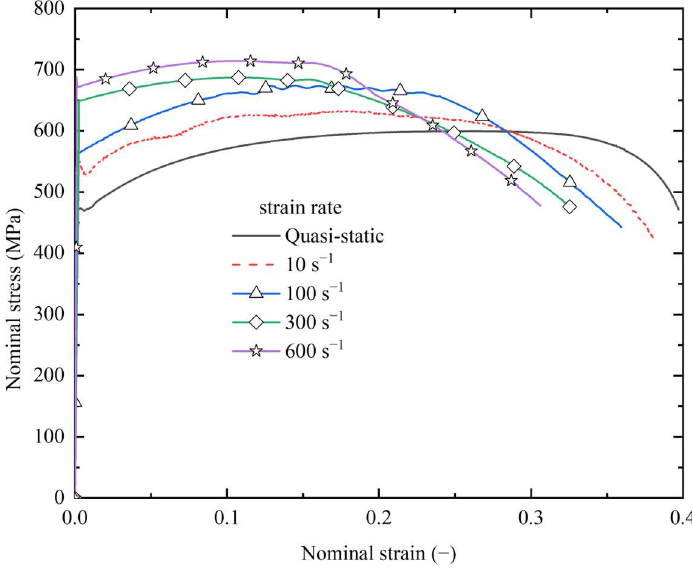
Figure 6. Test machines for unidirectional tensile tests of the material: ( a ) universal tensile test ma- chine for quasistatic tension; ( b ) test machine for dynamic tensile test.